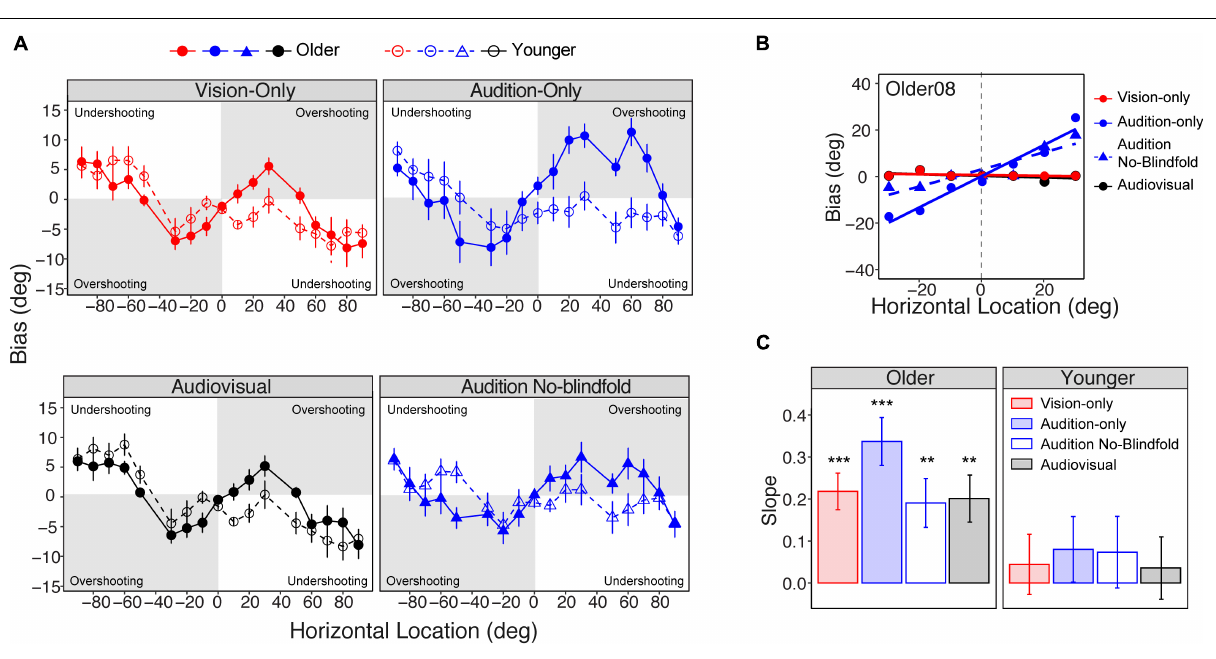
FIGURE 5 | Localization bias. (A) The average biases across the seventeen locations in the four conditions for the older and younger groups, respectively. Overshooting and undershooting are annotated on each plot. (B) Linear regressions of bias on the central locations (–30 ◦ to 30 ◦ ) in an example subject. (C) Bar plots representing the average slopes of the linear regression in the four conditions for the older (left panel) and younger (right panel) groups, respectively. The error bars represent standard errors. Statistical asterisks represent that the slope is significantly larger than 0. *** p < 0.001; ** p <